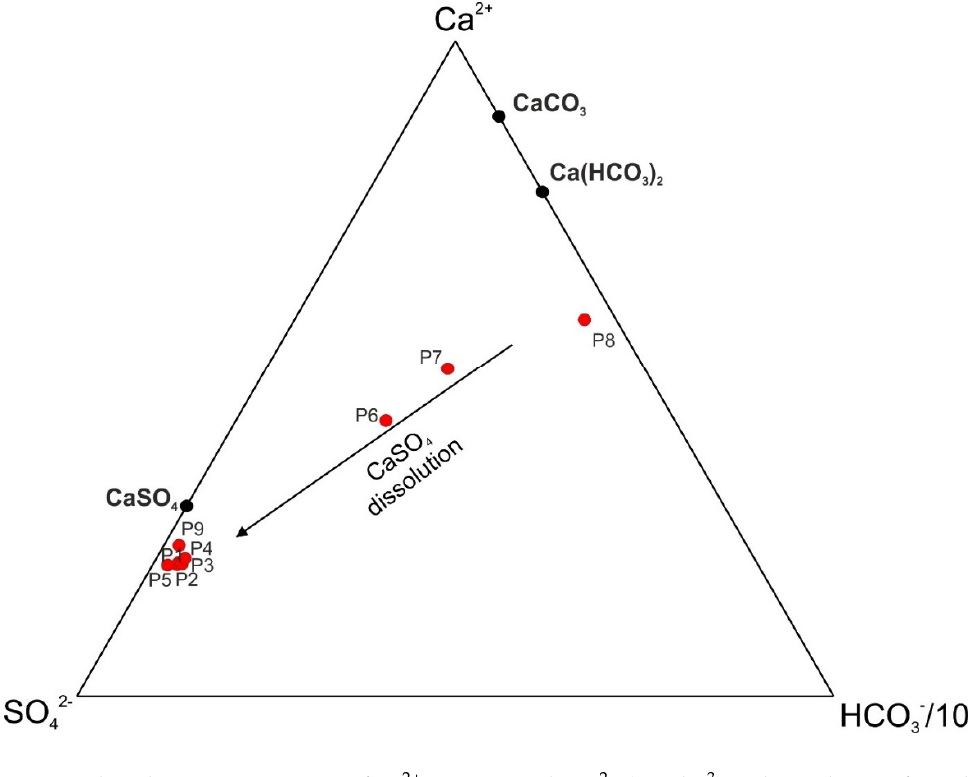
Figure 7. The relative concentration of Ca 2+ , HCO 3 − and SO 42 − (mg/dm 3 ) in thermal water from the study area (after [79–81]).